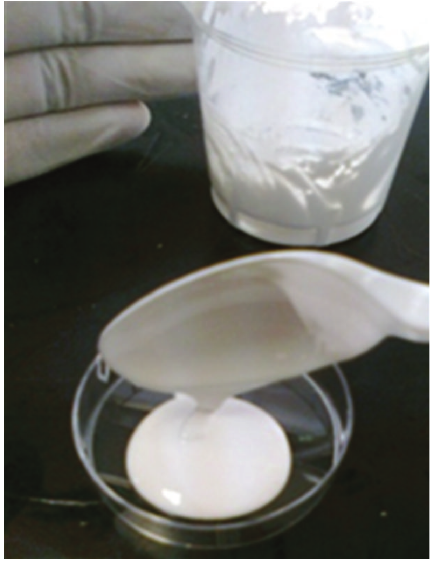
Figure 3: Pouring the well-mixed paste into a Petri dish.